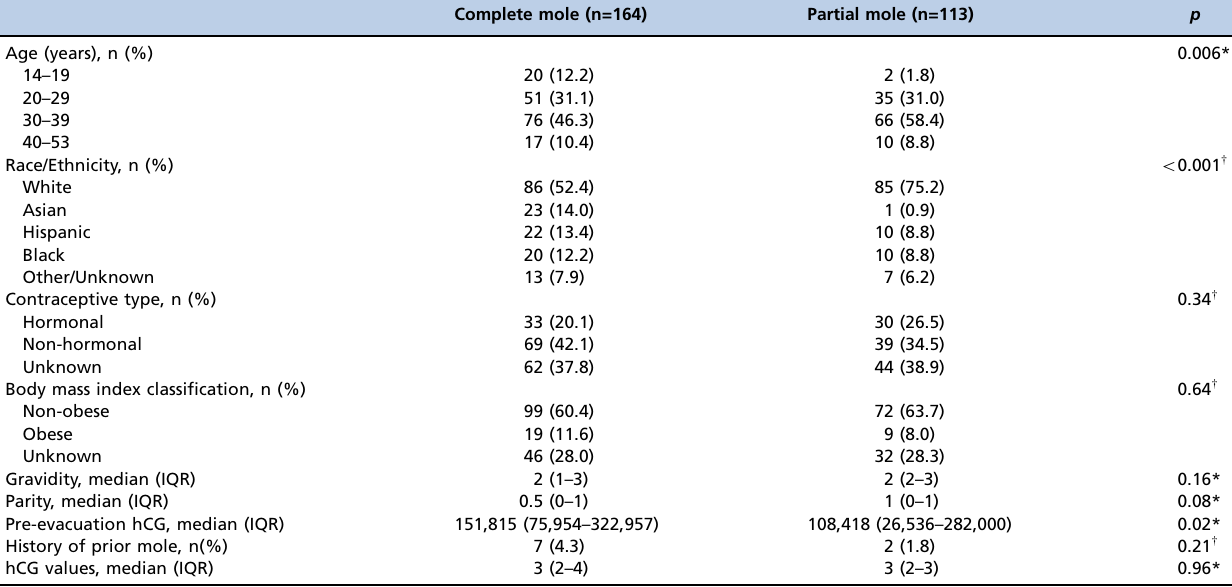
Table 1 - Clinical characteristics of patients by the type of molar pregnancy